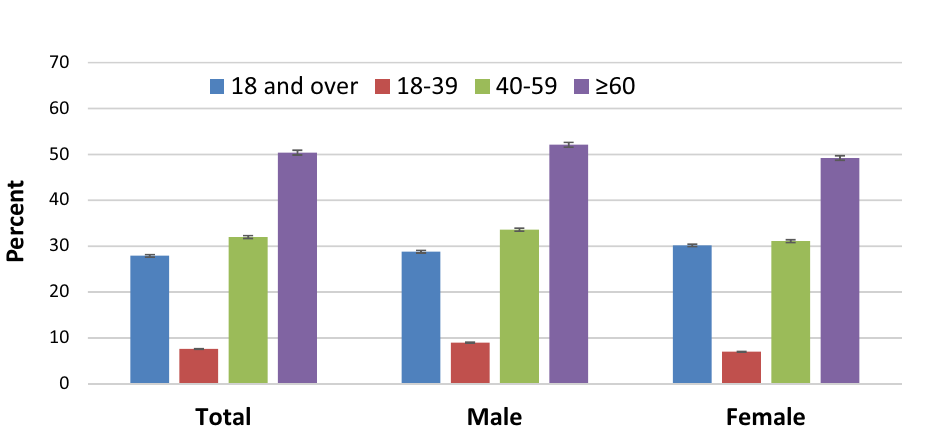
Figure 1. Prevalence of HTN among adults aged 18 and over, by age: All of Us , 2018–2019; ages 18 and over (blue), 18 to 39 (red), 40 to 59 (green), and 60 and over (purple) years. All estimates are age adjusted using the census population size at each age group as of July 1, 2018, based on https:// www. census. gov/ newsr oom/ press- kits/ 2019/ detai led- estim ates. html. Error bars show 95% confidence intervals for HTN prevalence estimates. Figure was created with Microsoft Excel for Mac, Version 16.46.